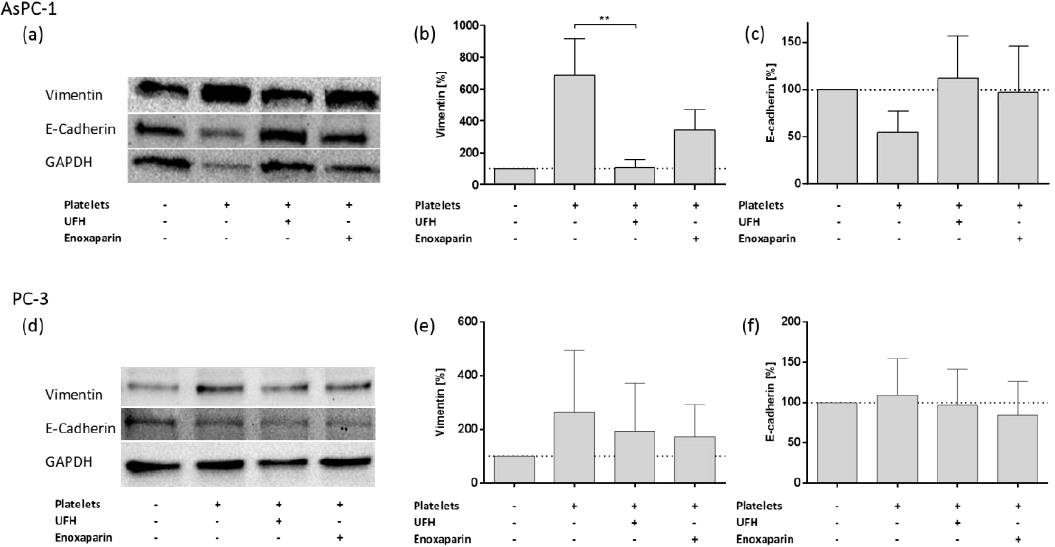
Figure 5. Western blotting of the expression profile of E-cadherin and vimentin in AsPC-1 and PC-3 cells. ( a ) Expression of E-cadherin and vimentin in AsPC-1 cells after treatment with platelets or platelets and UFH or platelets and enoxaparin for 72 h, respectively. ( b ) Quantification of vimentin expression by pixel density measurements in AsPC-1 cells, data of three independent experiments. Asterisks indicate statistical significance: ** p ≤ 0.01. ( c ) Quantification of E-cadherin expression by pixel density measurements in AsPC-1 cells, data of three independent experiments. ( d ) Expression of E-cadherin and vimentin in PC-3 cells after treatment with platelets or platelets and UFH or platelets and enoxaparin for 72 h. ( e ) Quantification of vimentin expression by pixel density measurements in PC-3 cells, data of three independent experiments. ( f ) Quantification of E-cadherin expression by pixel density measurements in AsPC-1 cells, data of three independent experiments.